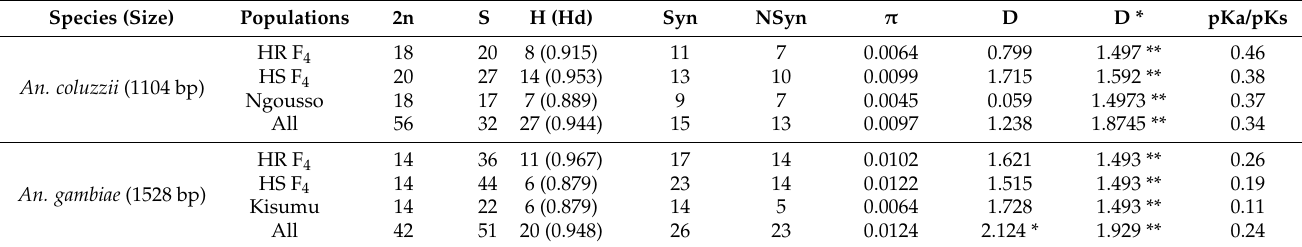
2n, number of unphased sequences; D, Tajima’s statistics; D *, Fu and Li’s statistics; H, number of haplotypes; n.a = non-attributed; Hd, haplotype diversity; Syn, Synonymous mutations; Nsyn, Non-synonymous mutations; π , nucleotide diversity; S, number of polymorphic sites; pKa, Synonymous polymorphism per site; pKs, non- Synonymous polymorphism per site; * = p < 0.05; ** = p < 0.02.